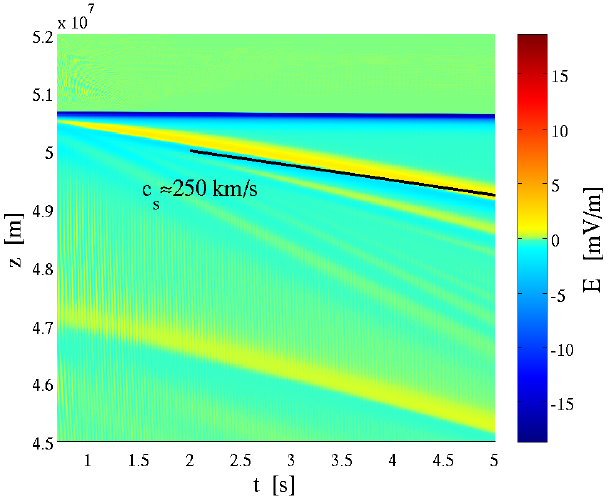
Fig. 4. The electric field in a z − t diagram. The ion acoustic speed is indicated by the slope of the black line.